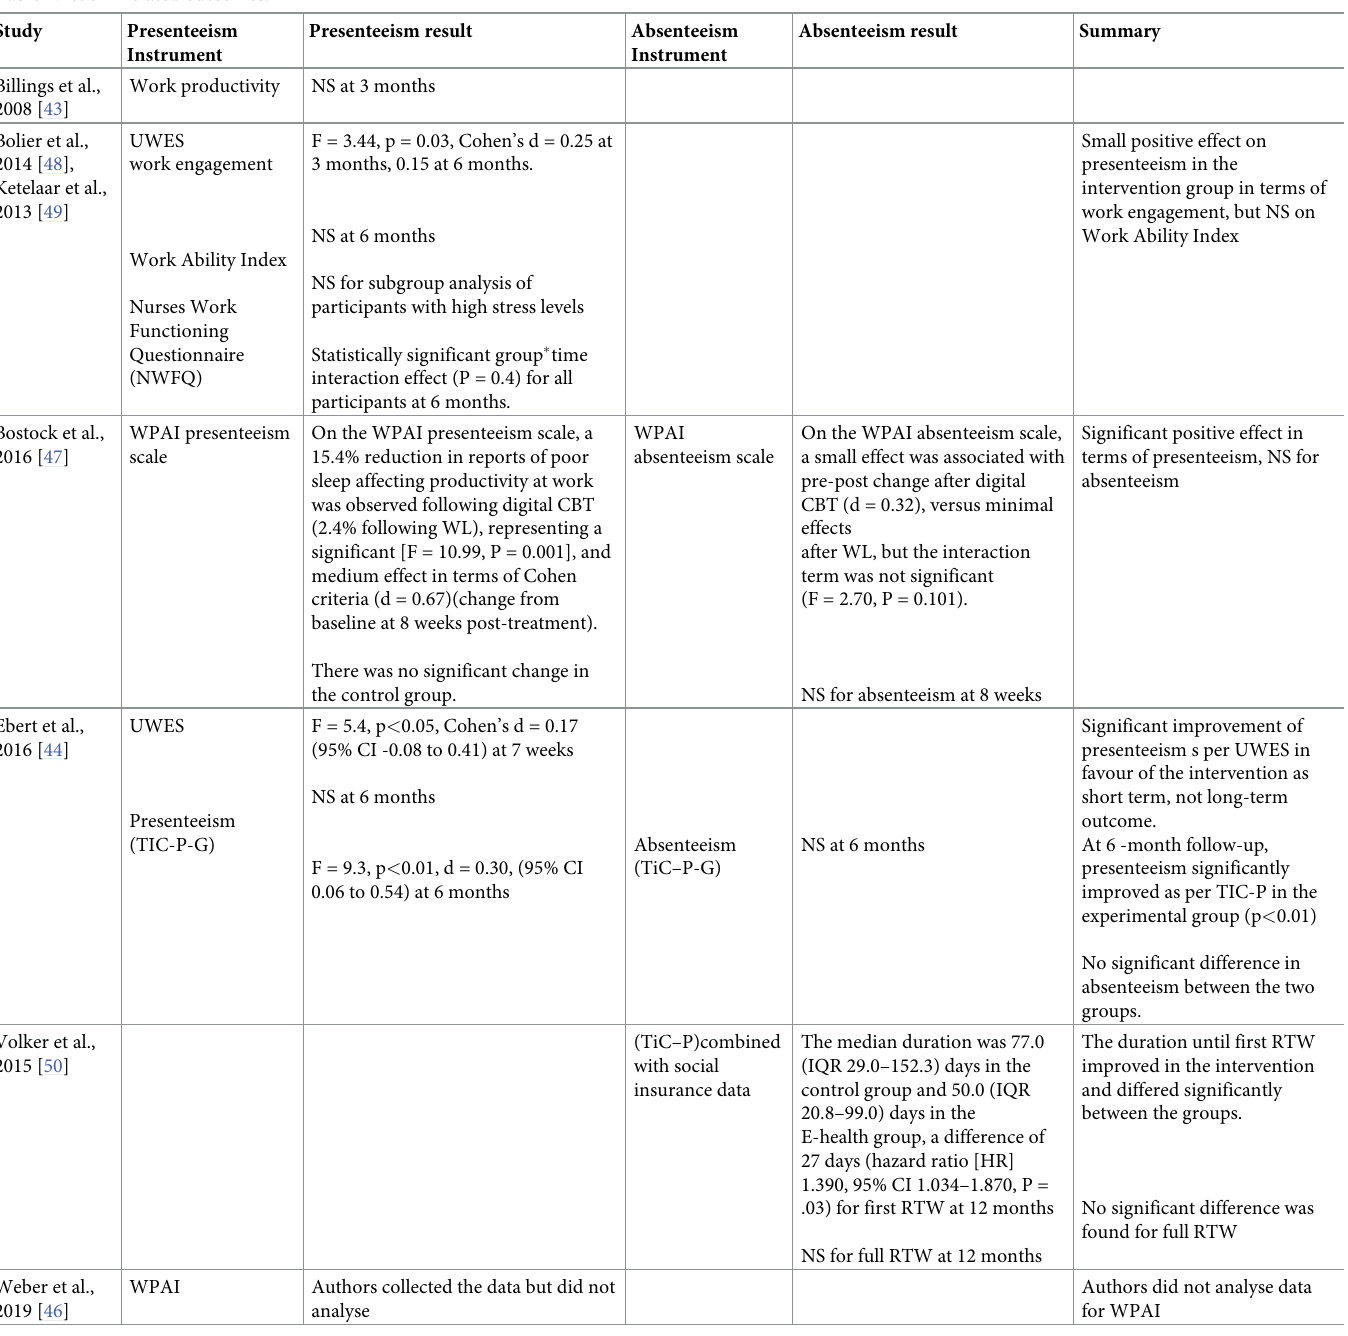
Table 4. Work-related